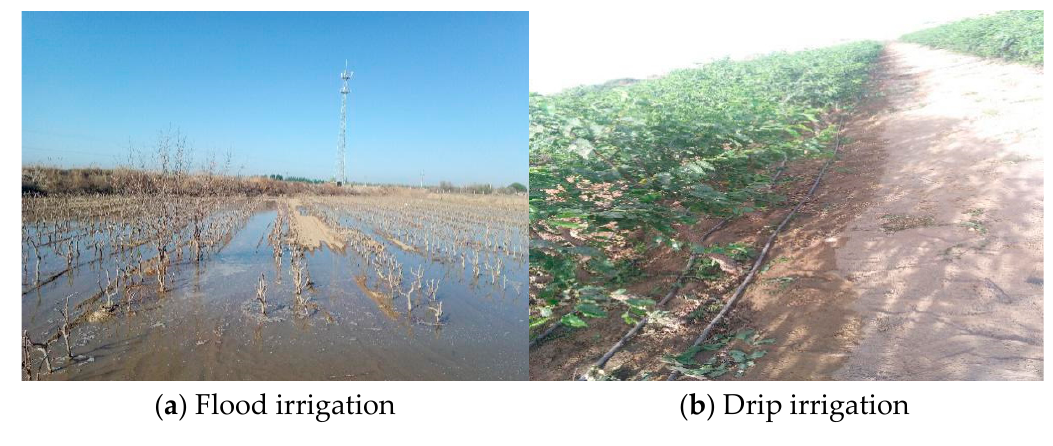
Figure 3. Different irrigation methods of jujube.